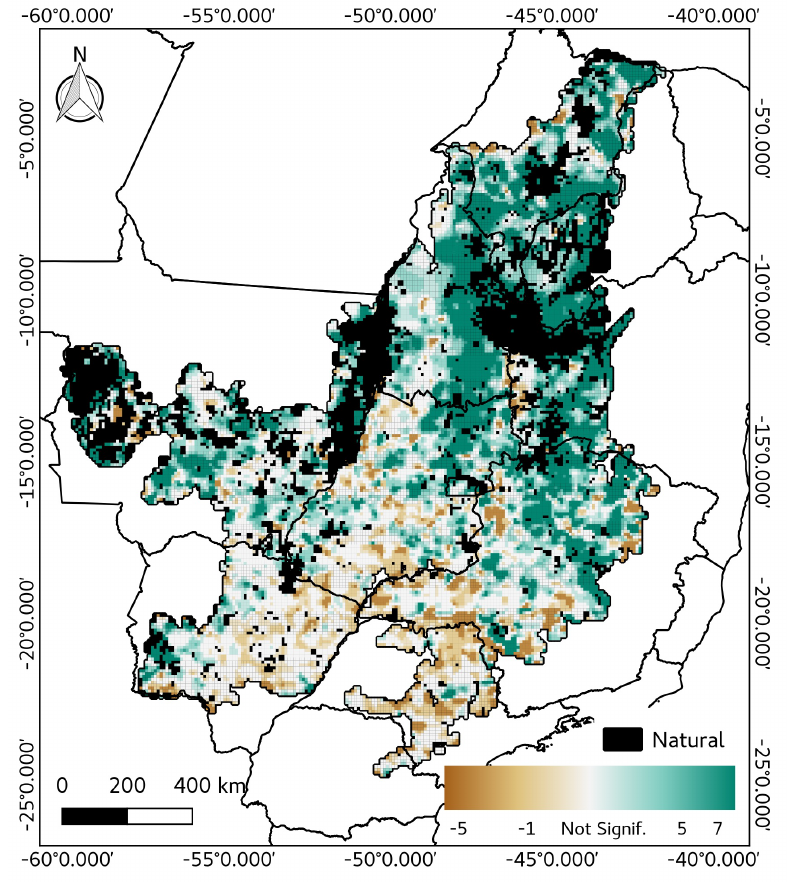
Figure 7. Local angular coefficients ( β 1) of GWR model for rural population